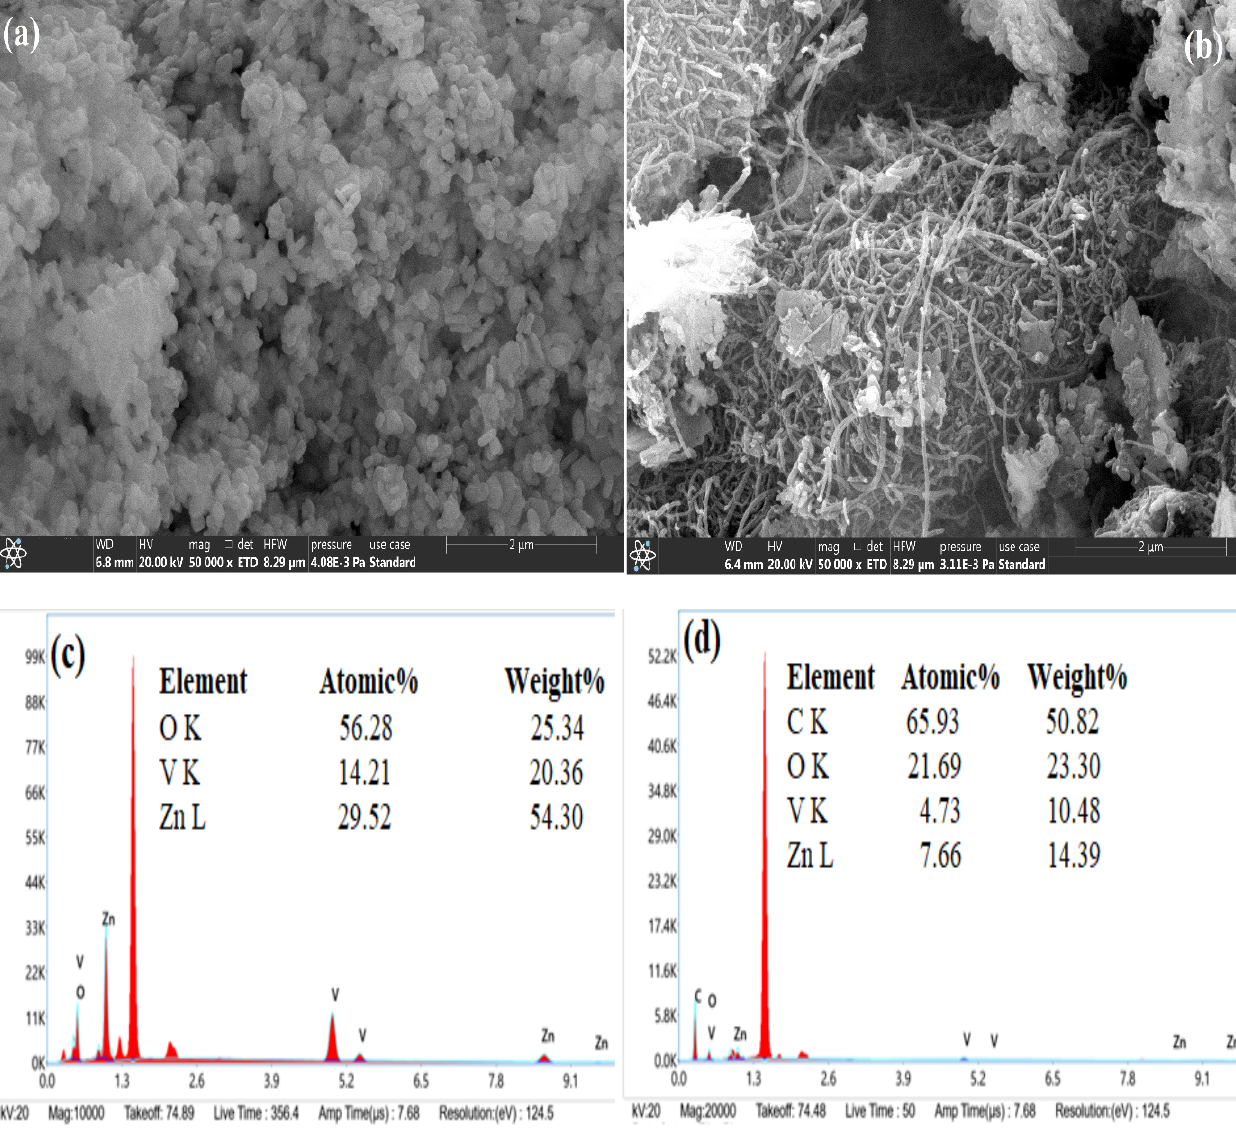
Figure 3. SEM image of ( a ) ZV, ( b ) ZV@MWCNT, ( c ) EDX spectra of ZV, and ( d ) EDX spectra of